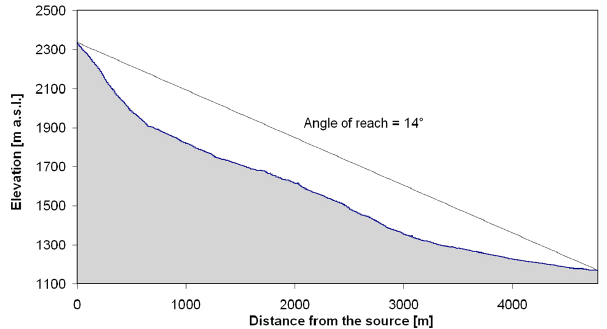
Fig. 7. Profile of the 2003 debris-flow in the Faucon torrent. A line for the identification of the angle of reach was positioned between the source area and the furthest point of the